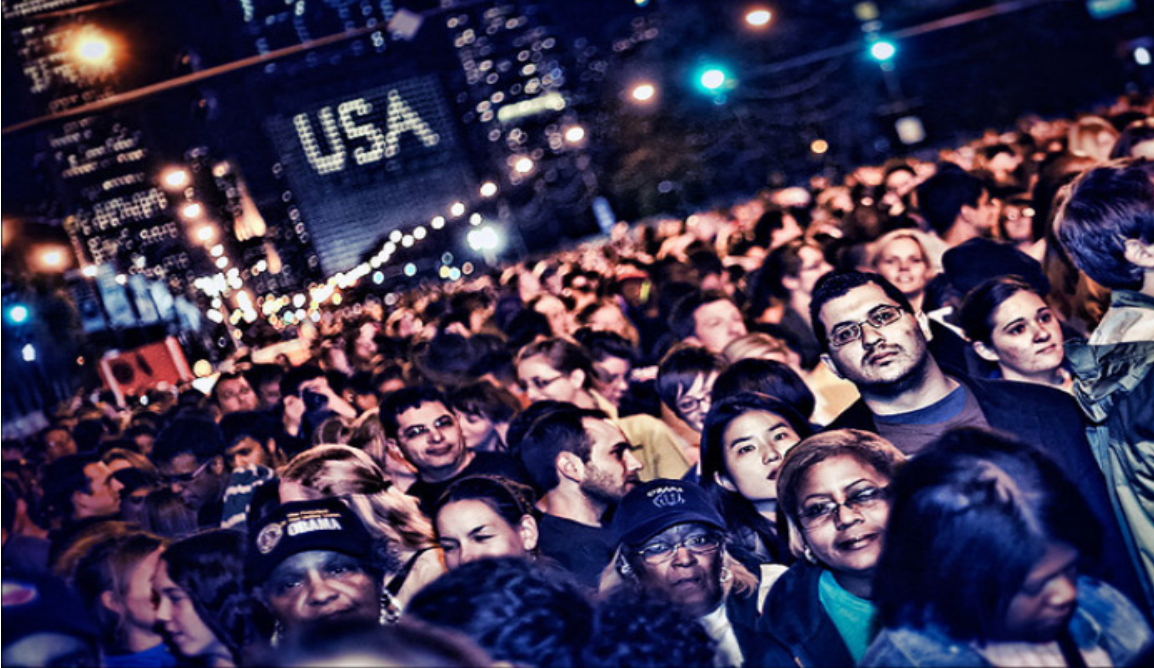
Figure 4. Grant Park, Chicago, Illinois, 2008 Election Night [46]. Photo Credit: Jerroid Marks.